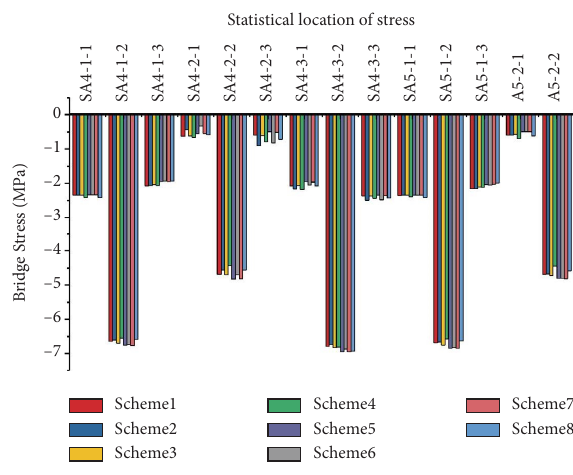
Figure 9: Comparison of beam element stress of each closure scheme in the bridge forming stage.